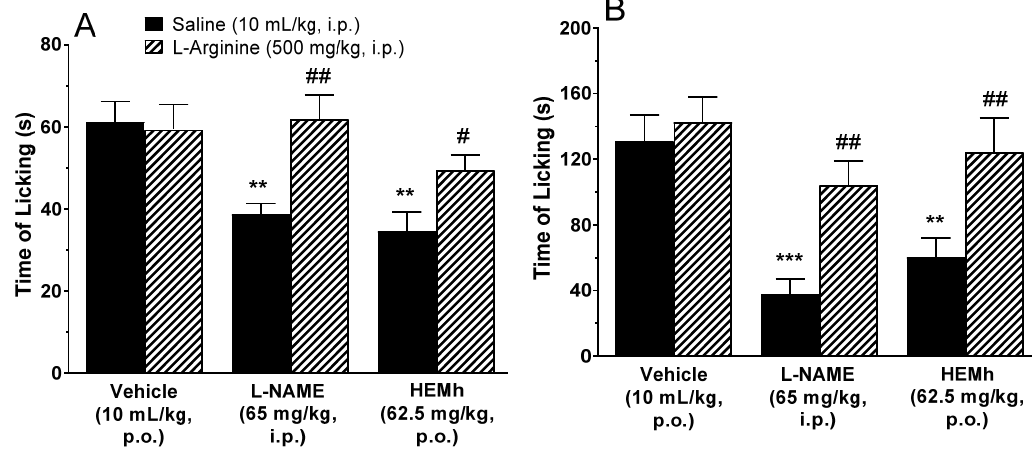
Figure 7. Involvement of the l -arginine-nitric oxide pathway in the antinociceptive activity of hydroalcoholic extract of the twigs of Machaerium hirtum (HEMh) in the formalin test (panel A —neurogenic phase and panel B —inflammatory phase). Each column represents the mean of 8–11 animals and the vertical lines indicate the S.E.M. The asterisks denote the significance levels compared with the vehicle control group (** p < 0.01 and *** p < 0.001) and a hashtag denotes the significance levels when comparing the l -NAME and HEMh treatments with their respective saline group ( # p < 0.05, ## p < 0.01) using one-way ANOVA (analysis of variance) followed by Tukey’s